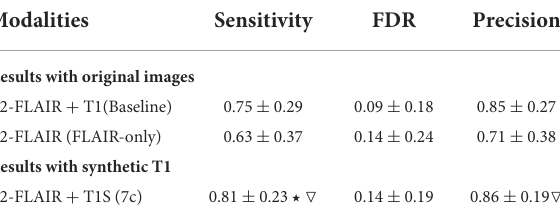
TABLE 2 New T2 lesion detection performance evaluation using the models shown in Figure